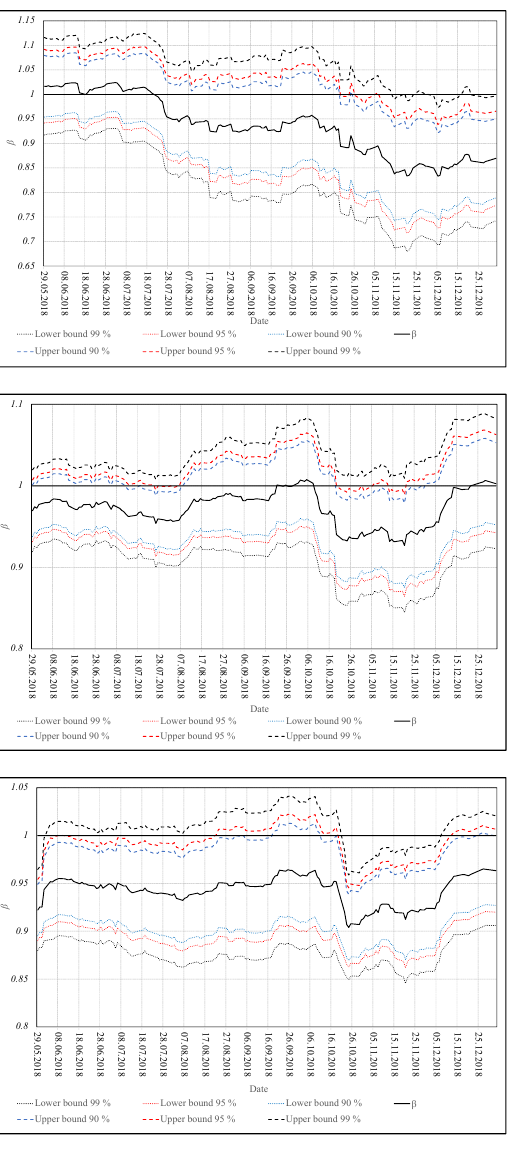
Figure 2. Sample estimators and confidence intervals for the beta coefficient of the equally-weighted portfolio constructed for the first k = 5 (top left ), k = 10 ( top right ), k = 15 ( middle left ), k = 20 ( middle right ), k = 25 ( bottom left ), and k = 30 ( bottom right ) assets included into the DAX index in alphabetical